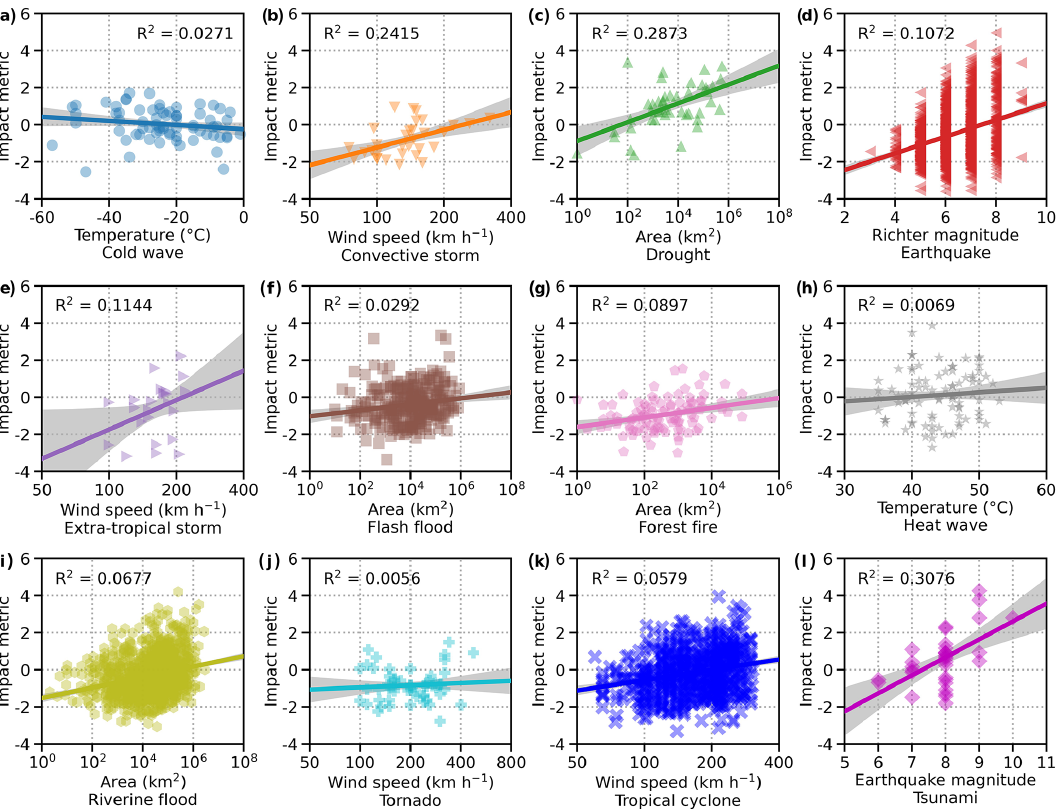
Figure 3. Simple linear regressions on impact metric against magnitude indicators. Impact metric is regressed on (a) minimum temperature of cold wave, (b) peak gust wind speed of convective storm, (c) total affected area of drought, (d) Richter magnitude of earthquake, (e) peak gust wind speed of extra-tropical storm, (f) total flooded area of flash flood, (g) total burnt area of forest fire, (h) maximum temperature of heat wave, (i) total flooded area of riverine flood, (j) peak gust wind speed of tornado, (k) maximum sustained wind speed of tropical cyclone, and (l) earthquake Richter magnitude of tsunami. Solid lines are regression lines. Shaded areas are the 95% confidence intervals of the corresponding regression